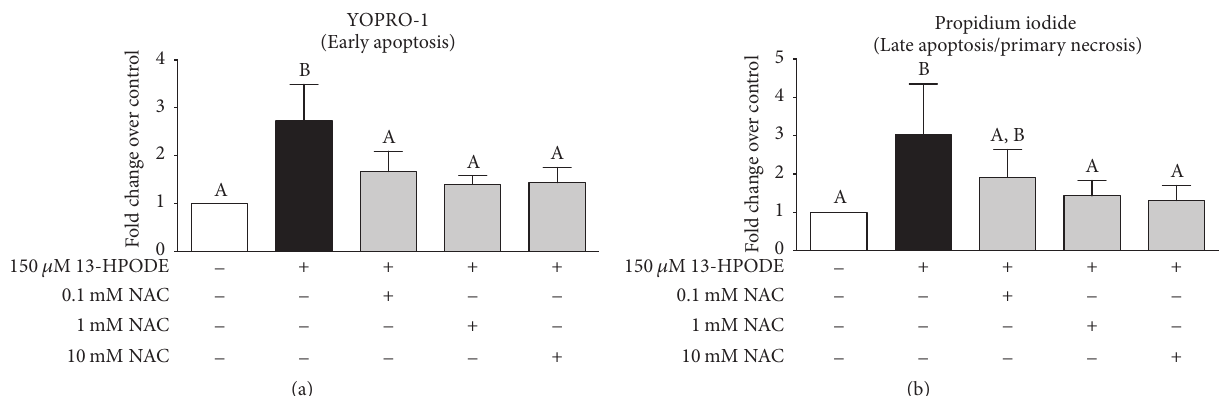
Figure 8: YOPRO-1 and propidium iodide of BMEC staining displayed as fold change over media control (open bar) after 6hr 150 𝜇 M 13- HPODE (light grey bars) or 6hr coexposure with 150 𝜇 M 13-HPODE or N-acetylcysteine (NAC, light grey bars). Different letters demonstrate a significant difference among media control and treatments as determined by a one-way ANOVA with Tukey’s post hoc correction. Significance declared at 𝑃 ≤ 0.05 .